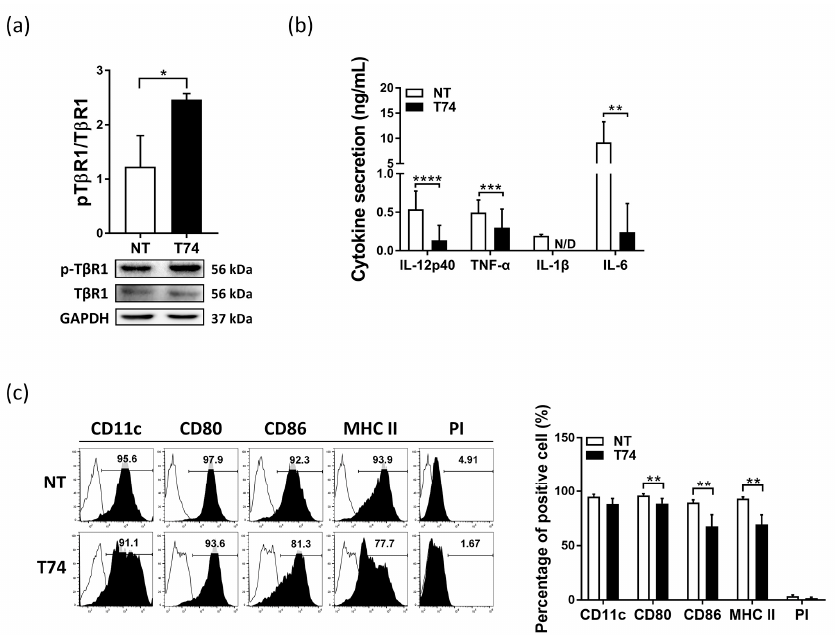
Figure 1. TGF- β receptor signaling agonist T74 blocks DC maturation. ( a ) Whole cell lysates prepared from T74-untreated DCs (NT) and T74-treated DCs (T74) were evaluated by western blotting for pTGFBRI (T β R1), TGFBRI. Values were normalized to GAPDH expression, n = 3. Data are representative of three independent experiments. ( b ) Pro-inflammatory cytokine secretion by T74-treated DCs (T74-DCs) was analyzed by ELISA, n = 5. ( c ) DCs were stained with fluorescence-conjugated antibodies specific for the indicated molecules and analyzed by flow cytometry. The histograms are representative of five independent mice. The bar graph shows the percentage of cells positive for each marker, n = 5. Data are expressed as the mean ± SEM. * p < 0.05, ** p < 0.01, *** p < 0.001, **** p < 0.0001. N/D: not detected.